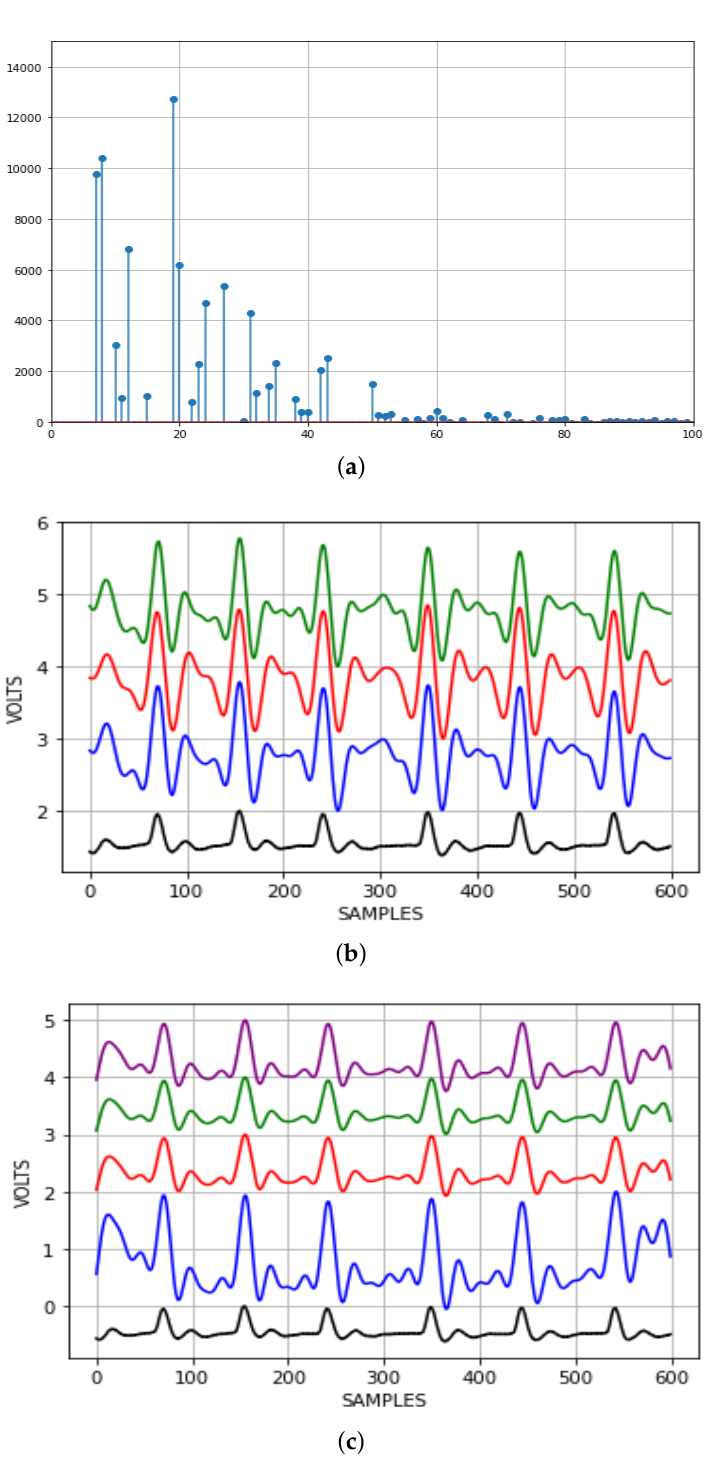
Figure 4. EMG signal analysis. ( a ) EMG signal in the frequency domain. ( b ) IIR filters: ( — ) Butter- woth, ( — ) Chebyshev, ( — ) Bessel, ( — ) original samples. ( c ) FIR filters: ( — ) Hamming, ( — ) Nutall, ( — ) Taylor, ( — ) Blackman, ( — ) original